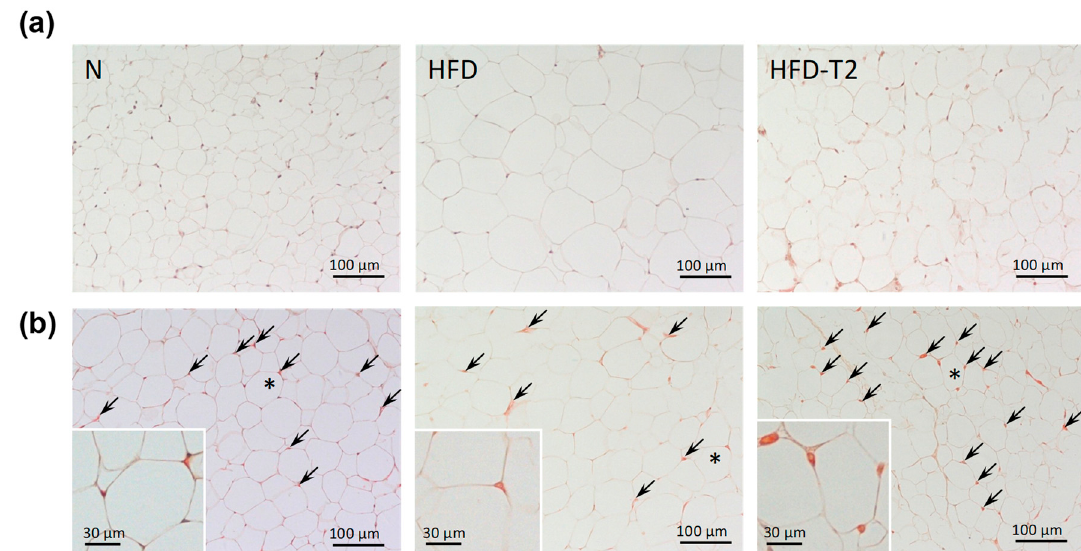
Figure 4. Effect of 3,5-T2 administration to rats fed a high-fat diet for 4 week on VAT morphology. ( a ) VAT was stained with hematoxylin & eosin (paraffin sections). ( b ) Vasculature was revealed by endothelial Bandeiraea simplicifolia agglutinin 1 (BS-1) staining (avidin-biotin complex- alkaline phosphatase (ABC-AP) method and fucsin as cromogen). BS-1-stained capillaries were indicated by arrows. Insets: high magnification of large adipocytes, as indicated by